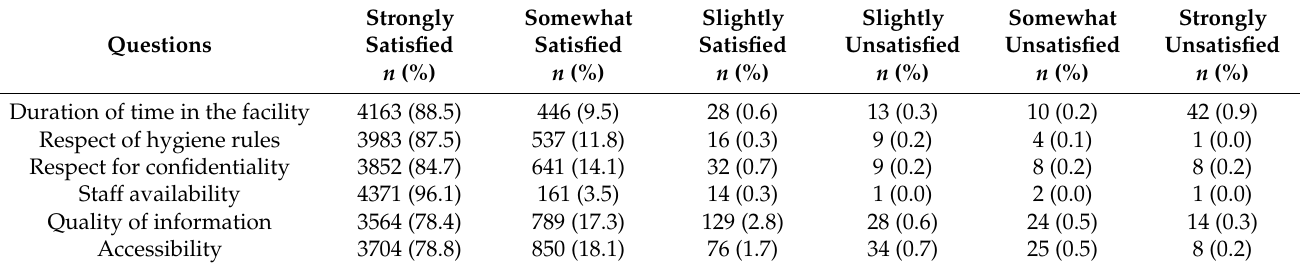
Table 3. Evaluation of the vaccination operation by the vaccinated